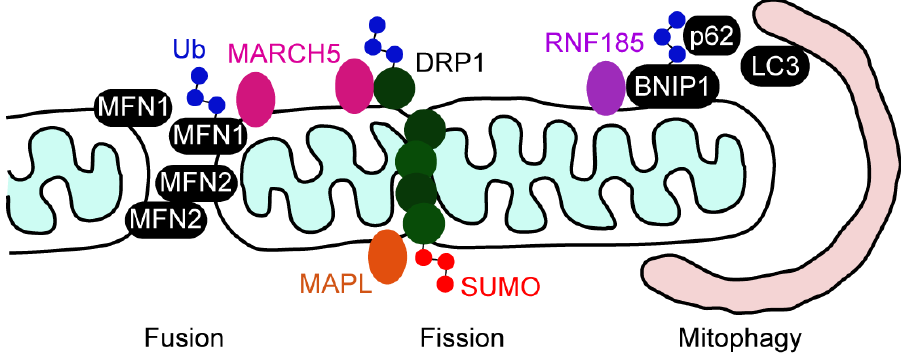
Figure 5. Proposed roles of the transmembrane RNF proteins in mitochondrial dynamics and mitophagy. MARCH5 may regulate mitochondrial fusion and fission by ubiquitinating MFN1 and DRP1. MAPL SUMO ligase stabilizes DRP1 and therefore promotes mitochondrial fission. RNF185-mediated ubiquitination triggers